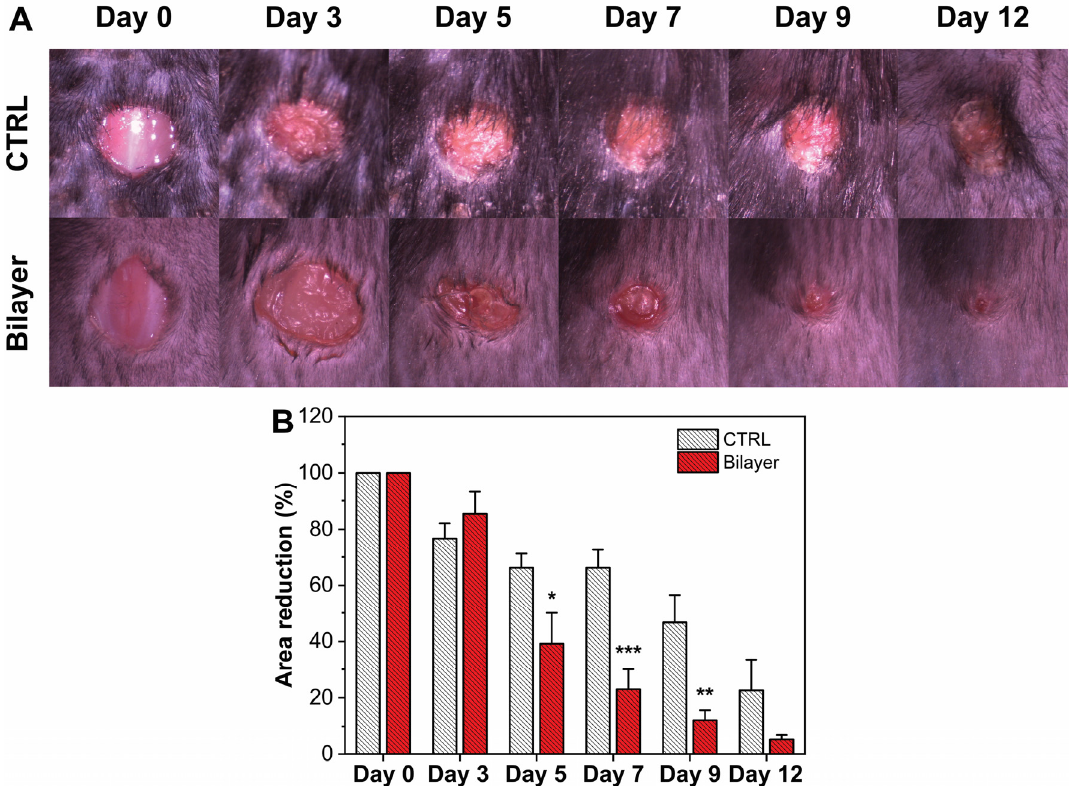
Figure 5. ( A ) Representative photographs of the skin of wound-healing mice at different time points (day 0, day 3, day 7, day 9, and day 12): untreated (no dressing) and bilayer dressing treated wounds are shown. ( B ) Time-course (days) of wound healing in mice untreated (white bars) and treated with the bilayer (red bars). * p < 0.05, ** p < 0.01, and *** p < 0.001, compared to untreated mice.